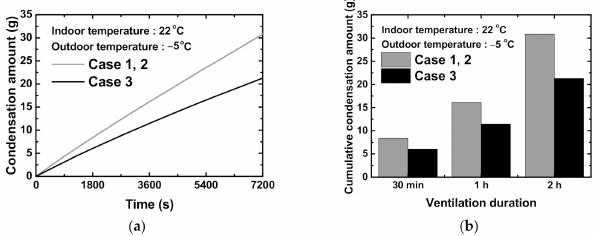
Figure 6. Results of Cases 1–3: ( a ) condensation quantity over time; ( b ) cumulative condensation quantity for di ff erent ventilation